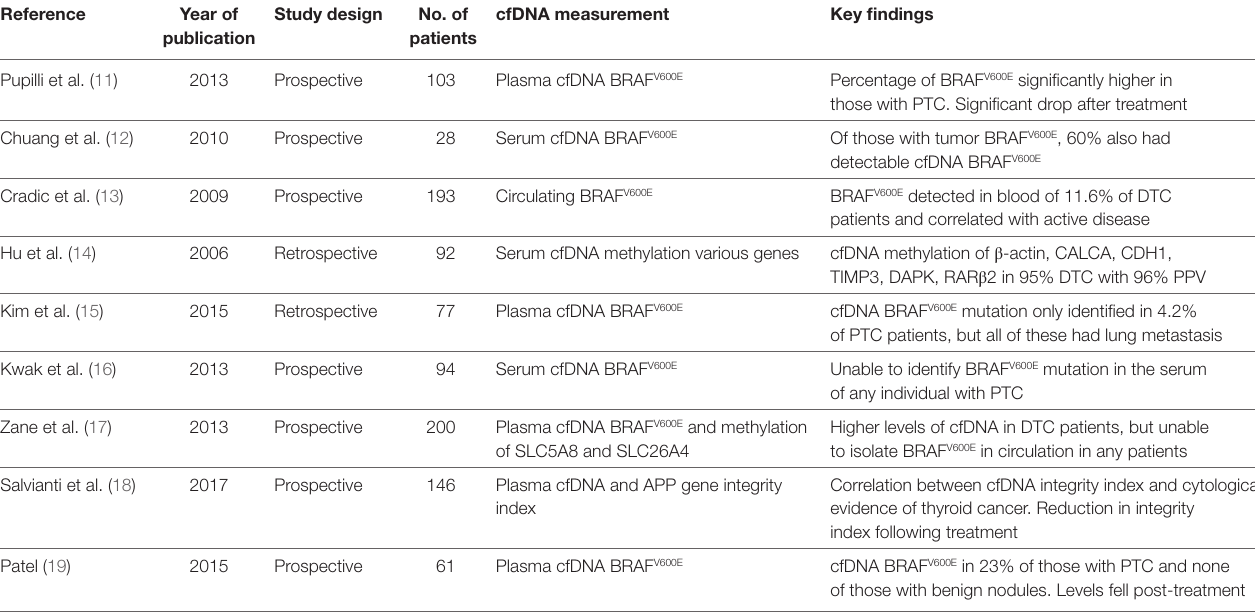
taBLe 2 | General study